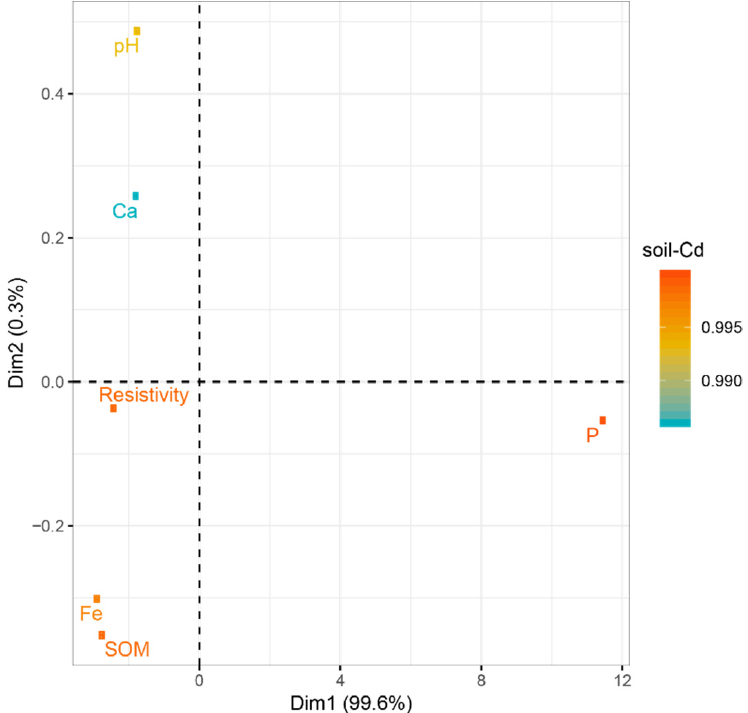
Figure 9. Principal component analysis (PCA) plot of six soil parameters compared to pseudo-total Cd determination. Resistivity is the parameter close to Cd in the order: resistivity > P > SOM > Fe > pH > Ca.